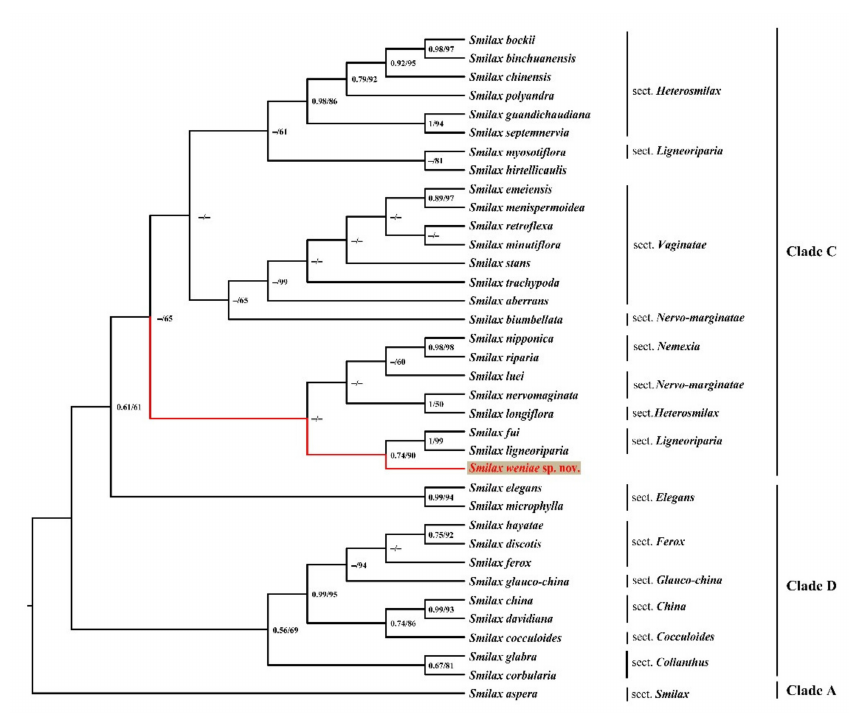
Figure 2. Maximum likelihood cladogram of the nrITS of Smilax weniae and 34 other Smilax species, representing an Old World Smilacaceae clade. Posterior probabilities (PP > 0.50) and bootstrap values (BS > 50%) based on Bayesian and maximum likelihood (ML) analyses are shown near the branches. Clade information adopted from Qi et al.